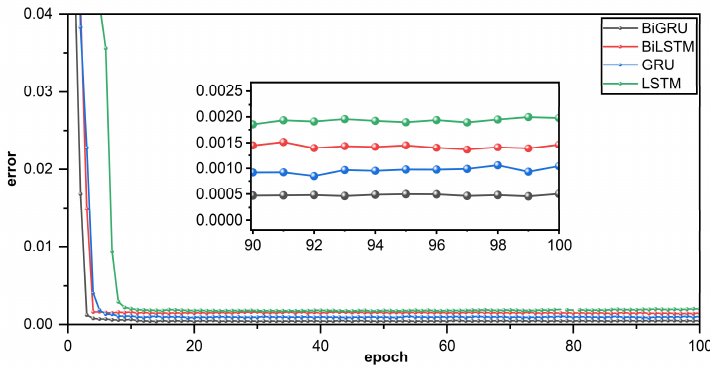
Figure 6. Comparative experiment loss value based on the bidirectional RNN structure.